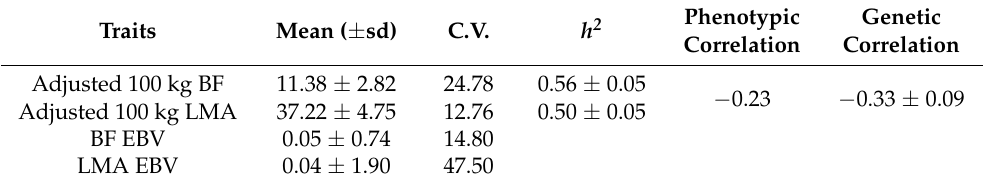
Table 1. Phenotype and heritability statistics for BF and LMA in three pig populations.